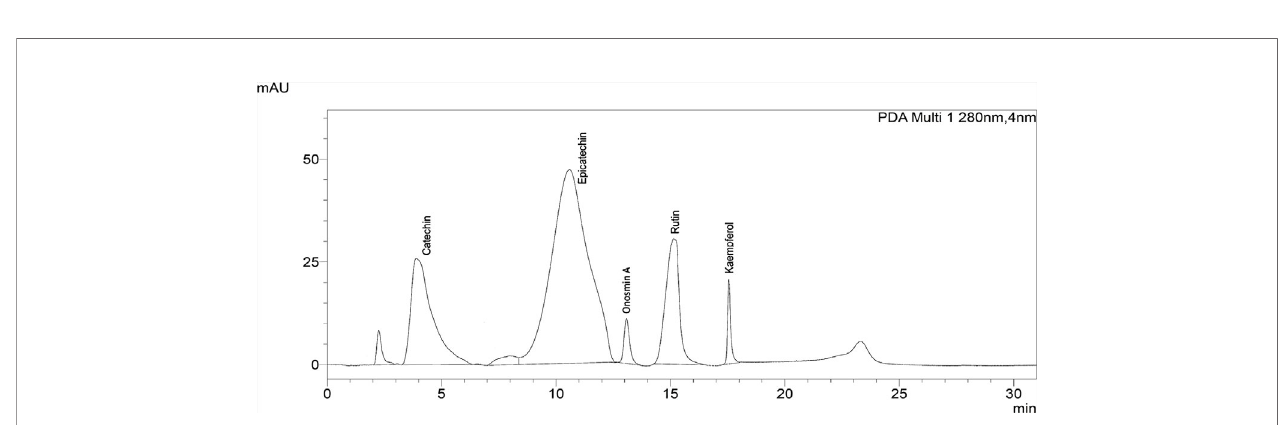
FIGURE 10 | Chromatogram of Obeth of O. bracteata showing presence of polyphenols as identi fi ed using HPLC analysis by reference compound.